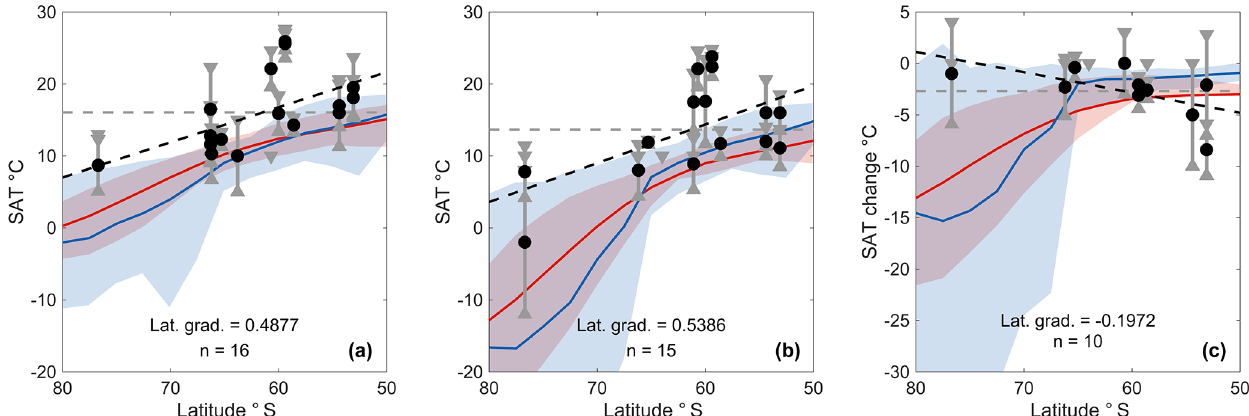
Figure 3. Latitudinal profiles of (a) late Eocene absolute temperature, (b) early Oligocene absolute temperature and (c) EOT temperature change from proxy records. The regional mean values are plotted as grey dotted lines and latitudinal gradients (calculated using ordinary least squares) as black dotted lines. Circles show proxy data mean values, while their uncertainty ranges and maximum–minimum limits are shown by the bars and triangles. The coloured lines show the zonal mean surface air temperature profile for the best HadCM3L (blue) and FOAM (red) simulations, with the shading showing the zonal maximum and minimum surface air temperature for each model.